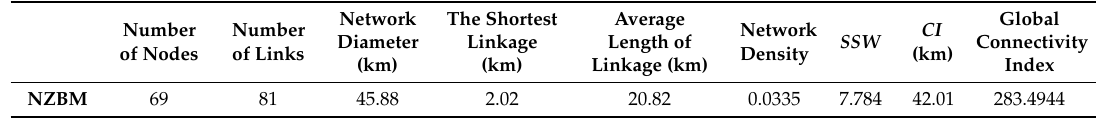
Table 1. Spatial parameters of NZBM.